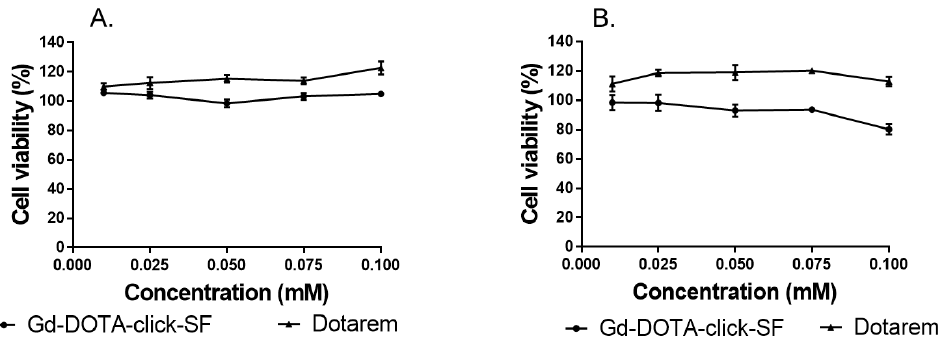
Figure 5. Cell viability CCK-8 assay with two different cell lines after 24 h of incubation: RAW 264.7 cells ( A ) and C166 endothelial cells ( B ).